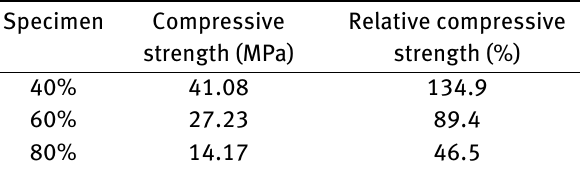
Table 15: Tensile strength of traditional mortar